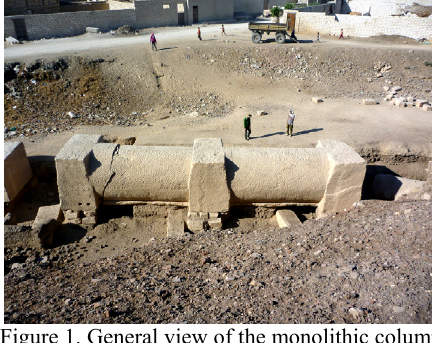
Figure 1. General view of the monolithic